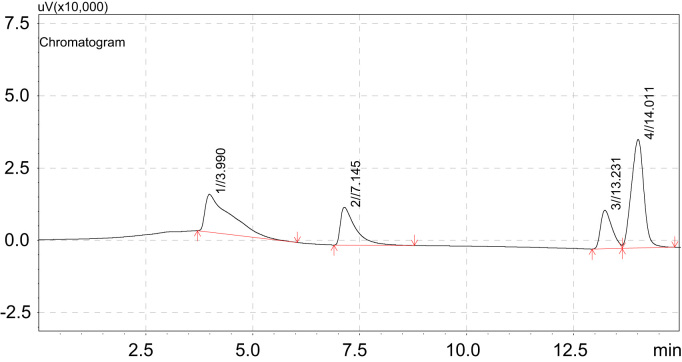
Sample standard.